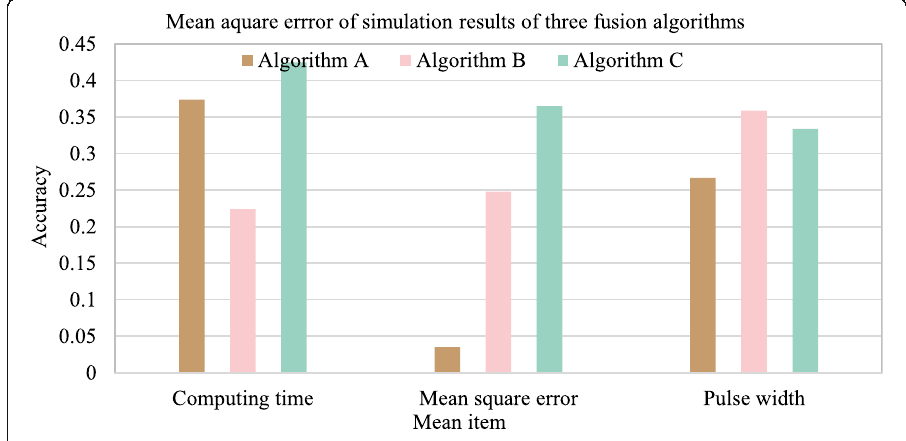
Fig. 7 Mean square error of simulation results of three fusion